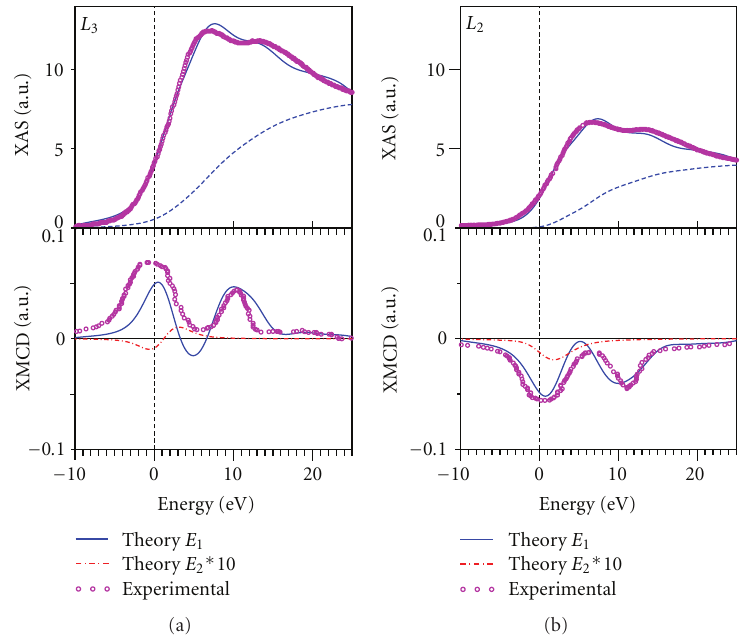
Figure 46: (upper panel) the experimental [293] (circles) and theoretically calculated [288] with the LSDA approximation (full lines) isotropic absorption spectra of CeFe 2 at the Ce L 2,3 edges. Dashed lines show the background spectra; (lower panel) experimental [293] (circles) XMCD spectra of CeFe 2 at the Ce L 2,3 edges in comparison with the ones calculated using the LSDA (full lines) approximation; the dashed-dotted lines show the contribution from the quadrupole E 2 (2 p → 4 f ) transitions multiplied by a factor of